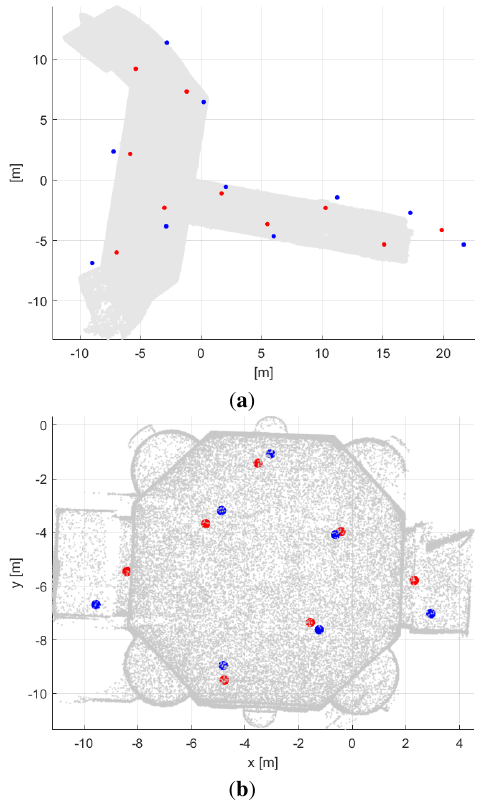
( b ) Figure 6. Photogrammetric 3D model accuracy assessment: com- parison with the TLS 3D model. Point clouds registered in local coordinates with the ICP algorithm. ( a ) Map of point-to-point distances. ( b ) Histogram of distances shown in ( a ). Table 2. Reconstruction error in case study